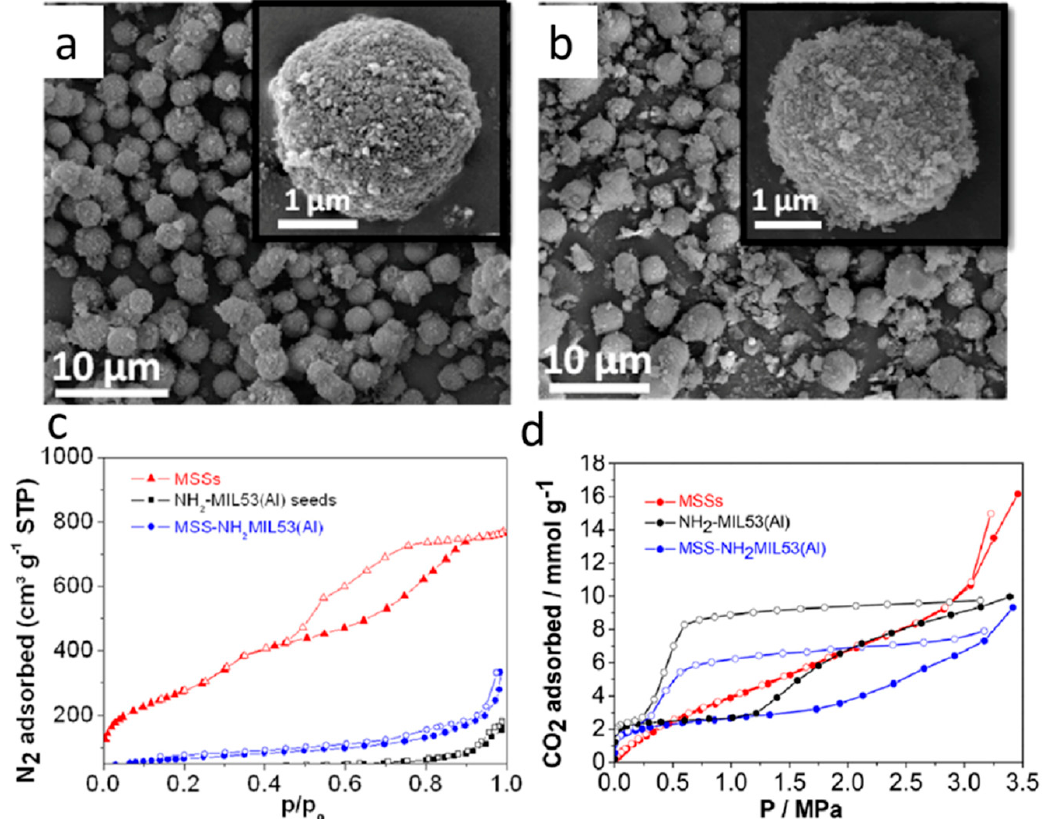
Figure 7. SEM images of SiO 2 coated with NH 2 -MIL-53(Al) crystals by ( a ) an ex situ seeding process with mesoporous silica spheres (MSSs) added into NH 2 -MIL-53(Al) seeds in N , N -dimethylformamide (DMF), or by ( b ) in situ seeding with MSSs were added to the synthesis gel of NH 2 -MIL-53(Al) seeds. ( c ) Adsorption–desorption isotherms of N 2 at − 196 ◦ C for SiO 2 , NH 2 -MIL-53(Al), seeds and SiO 2 -NH 2 MIL53(Al) samples. ( d ) Adsorption–desorption isotherms of CO 2 at 0 ◦ C for SiO 2 , NH 2 -MIL-53(Al), and SiO 2 -NH 2 MIL53(Al) samples. Solid and open symbols correspond to adsorption and desorption, respectively. Reproduced from [110], with permission from Elsevier, 2016.